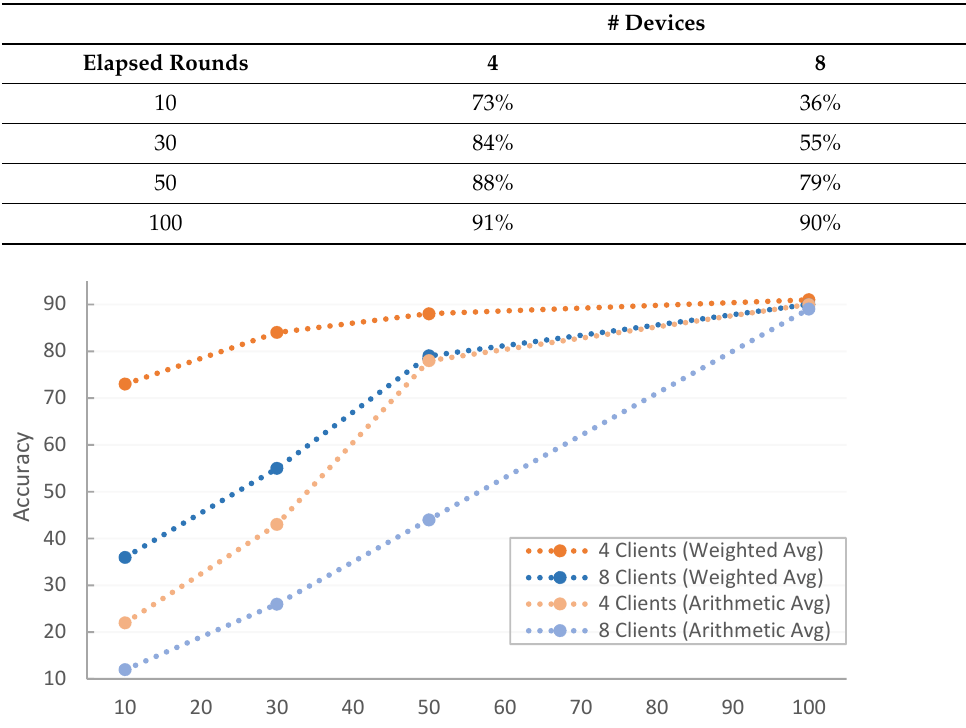
Table 4. Average accuracy for a weighted average aggregation method using nonuniformly dis- tributed datasets with 4 devices (15%, 25%, 60%, and 0.0002% of CIFAR10 images) and 8 devices (two clients with 7.5%, two with 12.5%, two with 30%, and two with 0.0002% of CIFAR10 images).